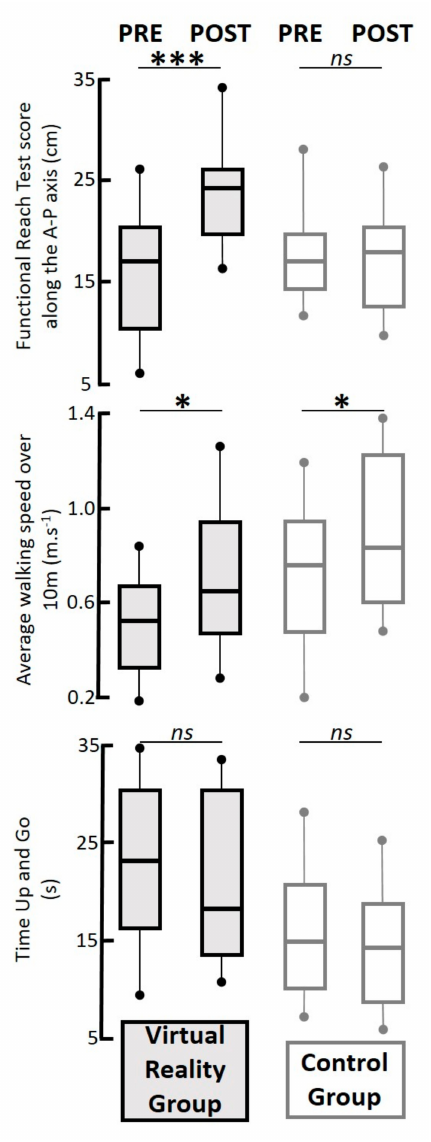
Figure 7. Boxplot graphs of the three clinical tests used to characterize the pre–post impacts of the rehabilitation programs (in column) in both groups (VR group with black lines and grey area; CTRL group with grey lines and white area). In each reported parameter, the box and whiskers report the values of all the recordings for all participants. The box is defined by the first and third quartiles. The thick line within the box represents the median value. The tenth and ninetieth percentiles are plotted as circles above and below the whisker bars. All participants in the VR group are reported in black lines with a grey area, and the CTRL group in grey lines with a white area. From top to bottom, the functional reach test score measured along the antero–posterior (A–P) axis in centimetres, the average walking speed over 10 m in m.s − 1 , and the Time Up and Go score in seconds. In each graph, the results are reported for all participants. ns , p > 0.05; *, p < 0.05; ***, p <